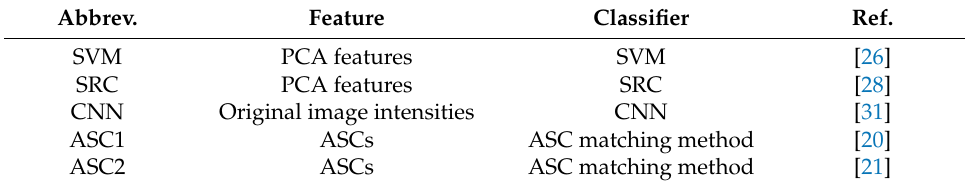
Table 2. Reference methods for comparison. SVM: support vector machine; SRC: sparse representation-based classification; CNN: convolutional neural network; PCA: principal component analysis.